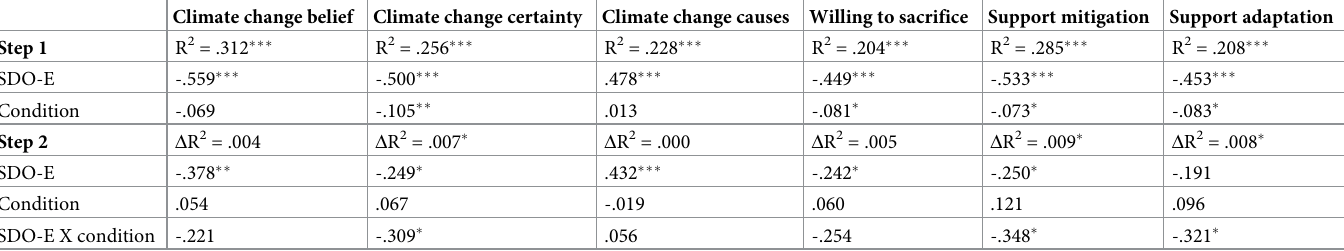
SDO-E X condition -.221